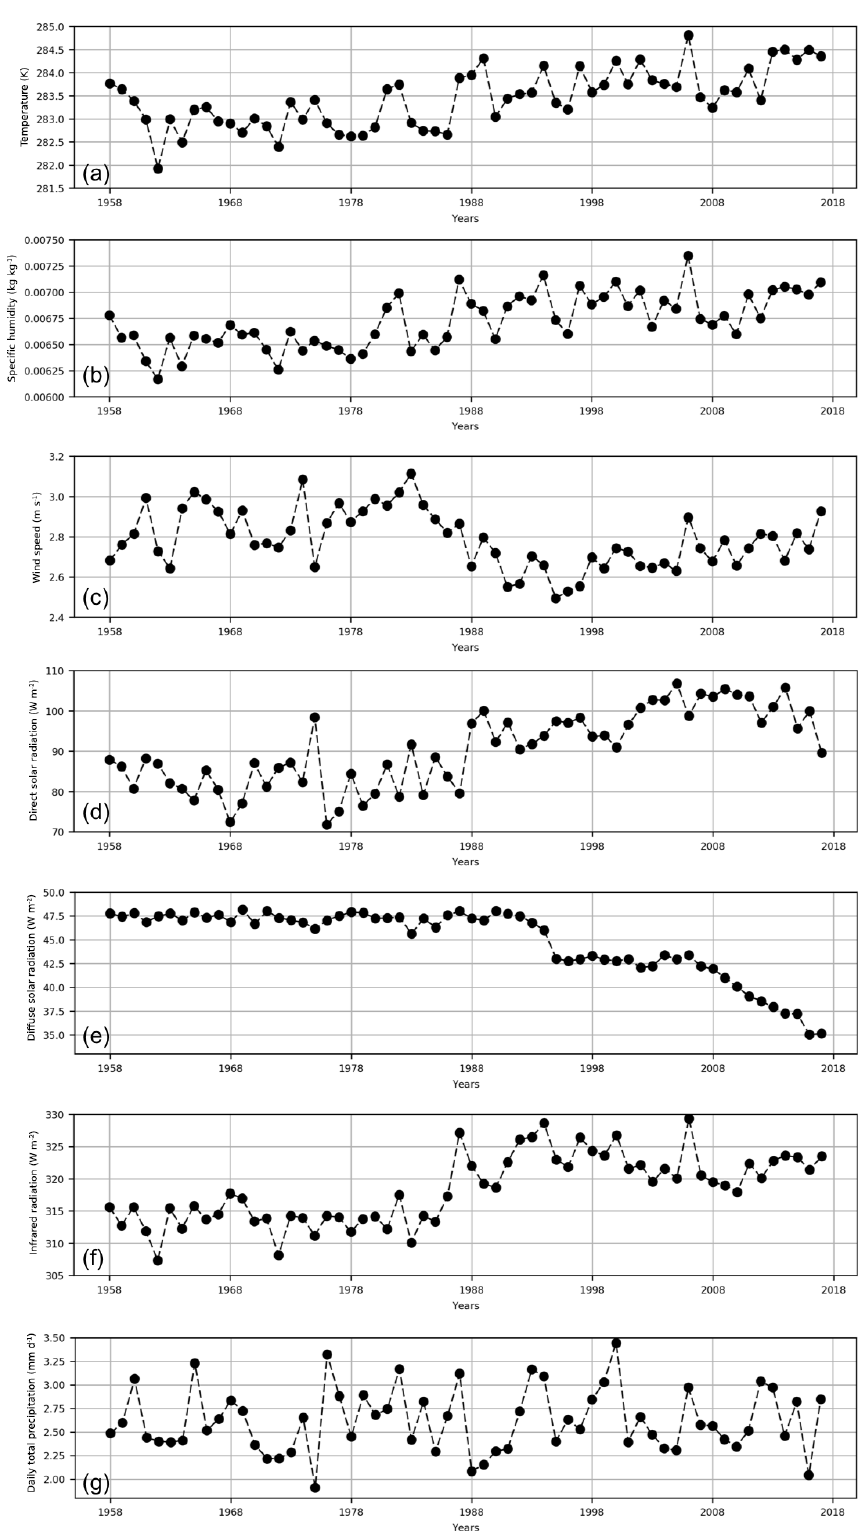
Figure 4. Annual average of the SAFRAN analysis of (a) air temperature at 2m, (b) specific air humidity at 2m, (c) wind speed at 10m, (d) direct solar radiation, (e) diffuse solar radiation, (f) infrared radiation, and (g) total precipitation rate.